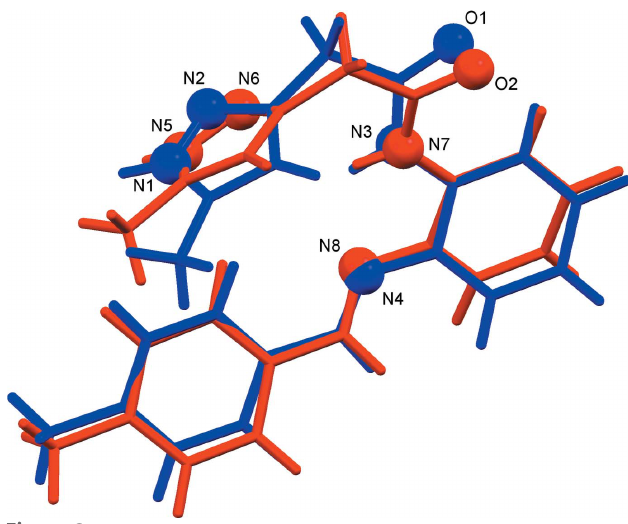
Figure 2 A molecular overlap view of inverted molecule 2 (red) on molecule 1 (blue).